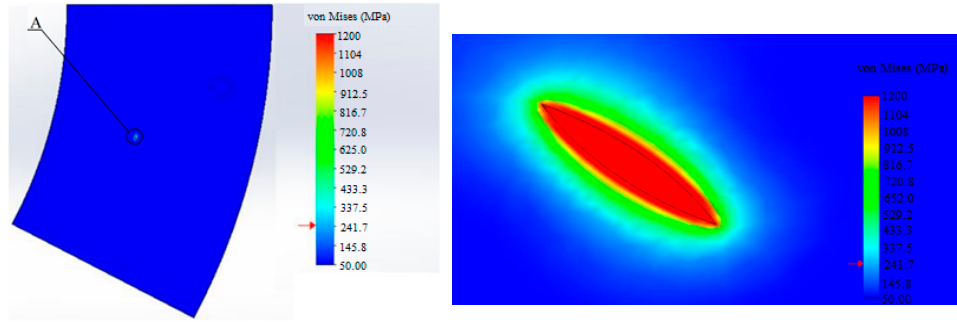
Figure 22. The stress field in the part of the thrust bearing disc and defect No. 4.